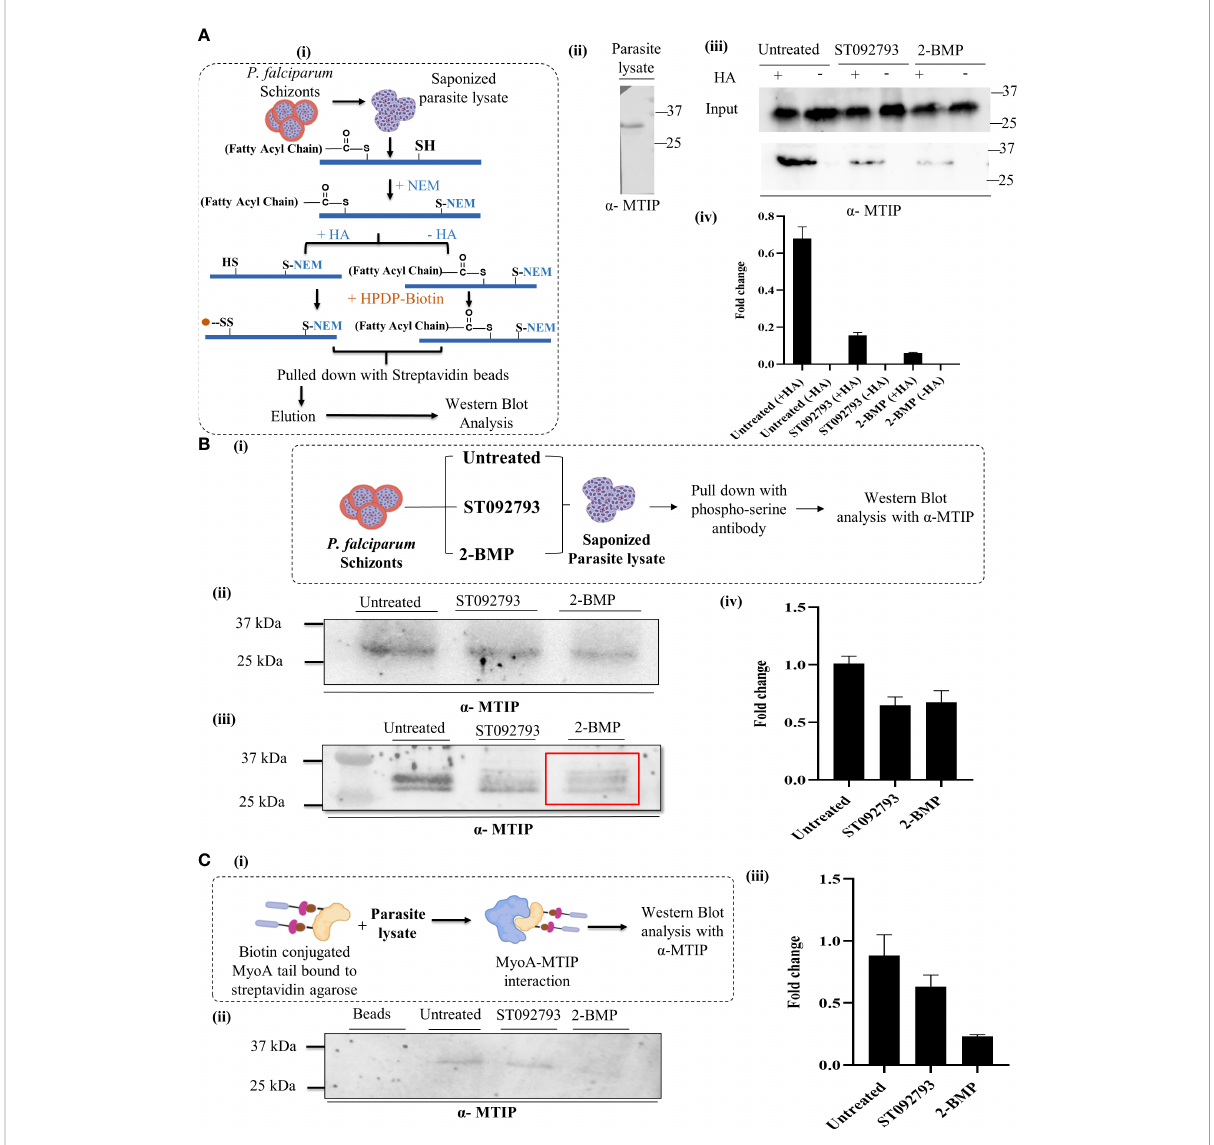
FIGURE 5 (A) (I) A schematic representation of acyl biotin exchange analysis to detect palmitoylation of parasite protein coupled with immunoblot analysis. (II) P. falciparum 3D7 lysate blotted using mouse anti-MTIP antibody (1:20,000 dilution in phosphate-buffered saline 0.1% Tween 20). A single band at 24 kDa representing MTIP was observed. (III) The representative immunoblot displayed inputs (upper panel) representing MTIP expression levels in untreated lysates and lysates treated with ST092793 and 2-BMP in presence and absence of HA. Immunoblots represent the MTIP expression in the ABE pulled fraction with and without HA treatment (lower panel). Low intensity of MTIP expression was detected in ST092793 and 2-BMP treated ABE pulled-down fraction in comparison to control. (IV) Bar graph represents the fold change in MTIP band intensity before and after ABE pull down. Two independent experiments have been performed, n = 2. (B) (I) Schematic representation to analyze the dynamic interplay between phosphorylation and palmitoylation status of MTIP. Schizont stage parasite were treated with ST092793, BMP alone. After treatment parasite lysates were subjected to pull-down analysis using phospho-serine antibody, eluate fractions were then probed with anti-MTIP antibodies. (II) Immunoblot represents the input showing equal MTIP expression in untreated and ST092793- and 2-BMP treated samples. (III) In the presence of 50 µM 2-BMP, the phosphorylation of MTIP (measured by pull-down using phospho-Ser antibody followed by probing with anti-MTIP) was predominantly reduced (red box) as compared to MTIP in untreated lane. (IV) Bar graph represents the change in fold intensity before and after pull-down using phospho-Ser antibody. (C) (I) Schematic representation of work fl ow to analyze the MTIP interaction with MyoA tail. (II, III) The immunoblot showed the synergistic impact of dual PTM on MTIP crosstalk with myosin A tail, in the presence of 50 µM 2-BMP. There was no MTIP band following pull-down using biotinylated myosin A tail as the bait. The graph denotes fold change in intensity of MTIP in comparison to inputs taken before pull-down with myosin A tail in individual lanes. Two independent experiments have been